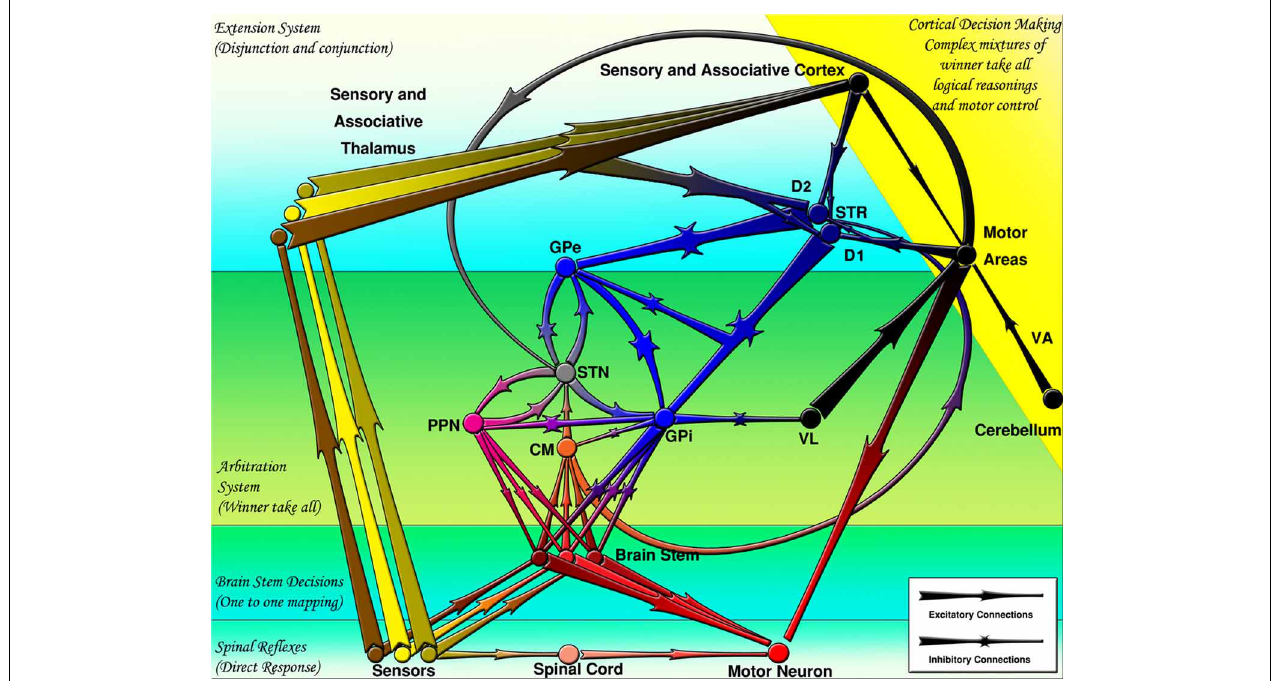
FIGURE 3 | The basal ganglia projections and connections to other CNS regions (excitatory and inhibitory projections are shown by arrows and stars respectively). Decisions are made by several mechanisms organized hierarchically.CM,centromedianthalamus;D1,D1receptordominantmedium